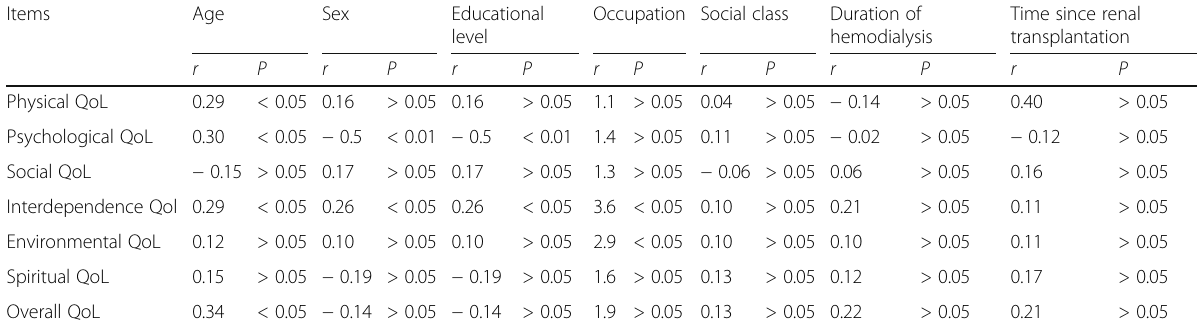
Table 4 Correlation between quality of life domains with sociodemographic and some clinical variables